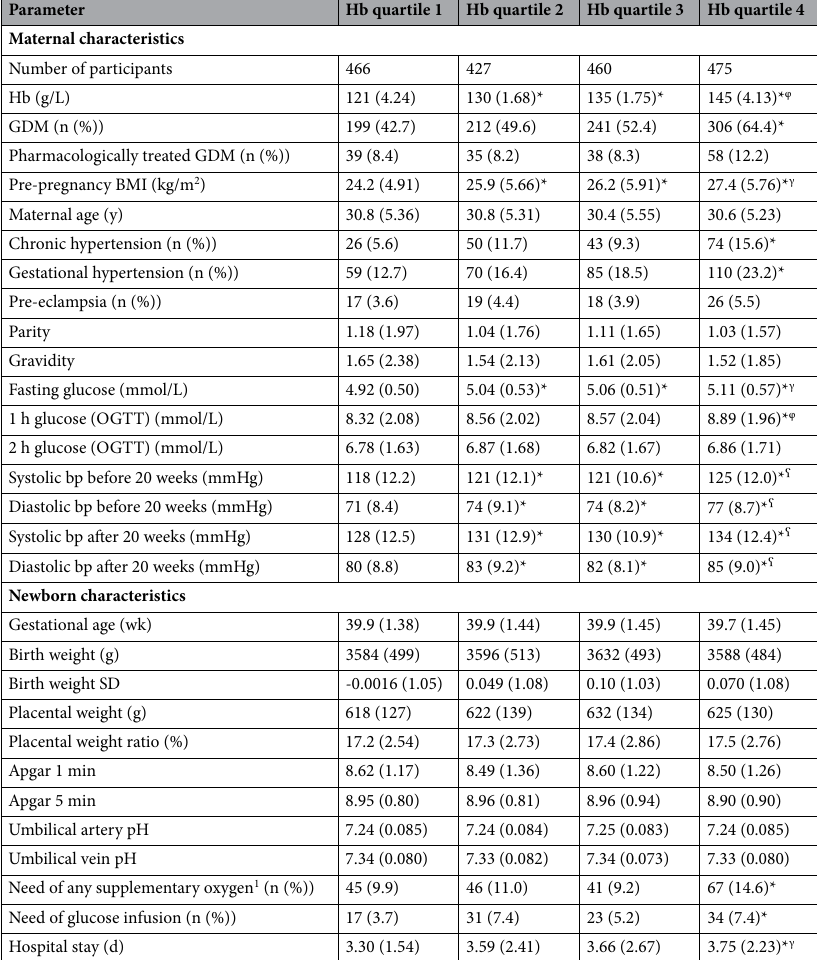
Table 2. Characteristics of the study population in four Hb quartiles. The values are mean with (SD) or number (n) with (%). Total participants (n = 1828). *Statistical significance when compared to Hb quartile 1. γ Adjusted for smoking and the gestational week hemoglobin was measured. φ Adjusted for smoking, the gestational week hemoglobin was measured and pre-pregnancy BMI. ˤ Adjusted for smoking, the gestational week hemoglobin was measured, pre-pregnancy BMI and chronic hypertension. 1 Need of any supplementary oxygen or respiratory support. Hb hemoglobin, GDM gestational diabetes mellitus, BMI body mass index, OGTT oral glucose tolerance test, bp blood pressure.